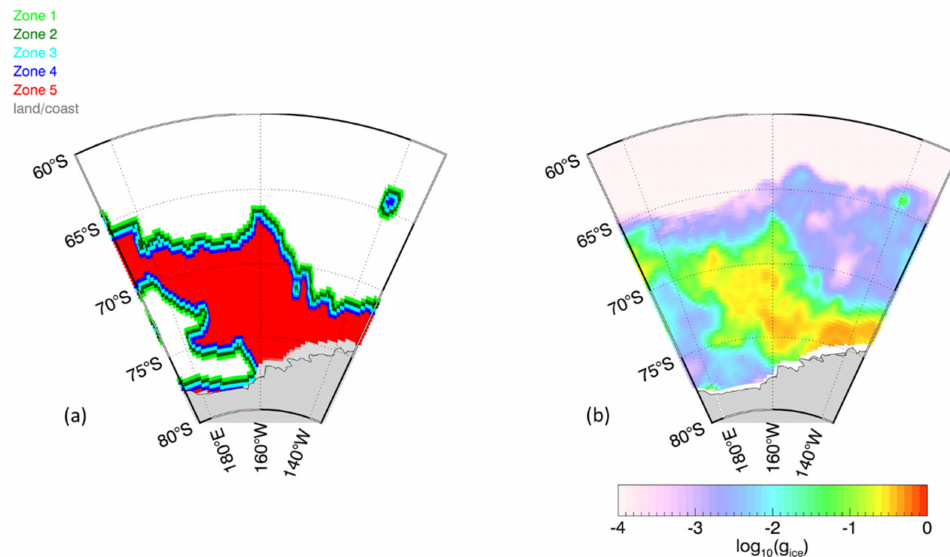
Figure 6. ( a ) Illustration of the sea-ice zones 0–5 for an area near the Antarctic ice shelf. Zone 0 (open ocean) observations are plotted white. The area near (65S, 140W) depicts a very large iceberg. ( b ) Antenna gain weighted sea-ice fraction g ice from the OSI-SAF SIC product